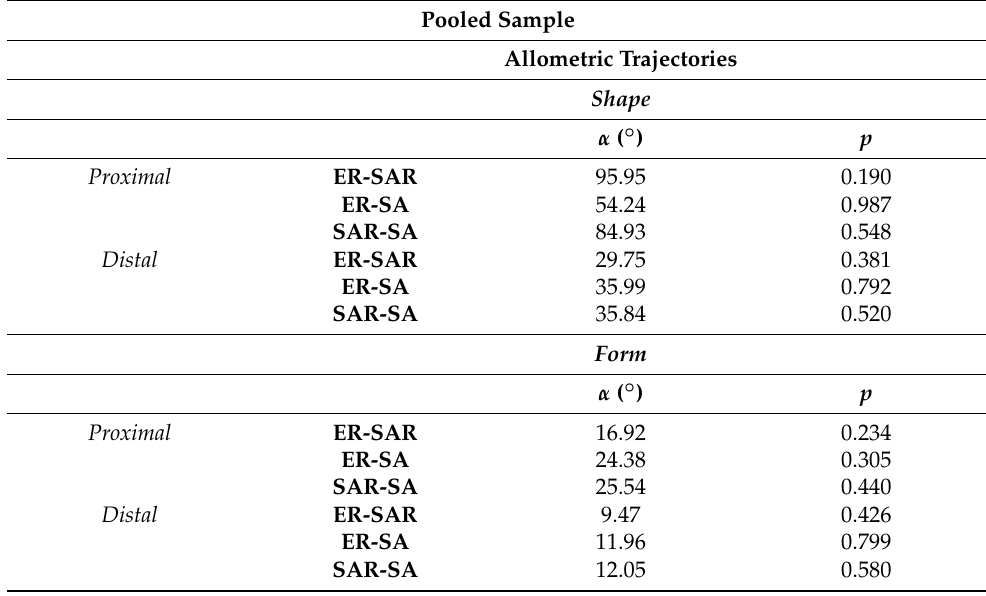
Table 3. Allometric trajectory comparisons among different populations computed with the pooled sample for proximal and distal fibular epiphyses in shape and form space. α ( ◦ ) indicates the angle of divergence of each trajectory in pairwise comparisons, with relative p -value ( p ). Pooled Sample Allometric